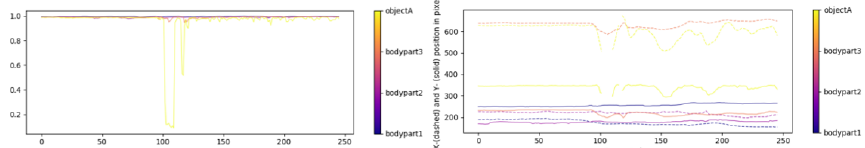
Figure 3. Comparison of spatiotemporal domain motion trajectories of different body parts. The tracking points of different protective body behaviors change their positions in space–time differently. The curves of these changes describe the spatiotemporal trajectories of different body parts.